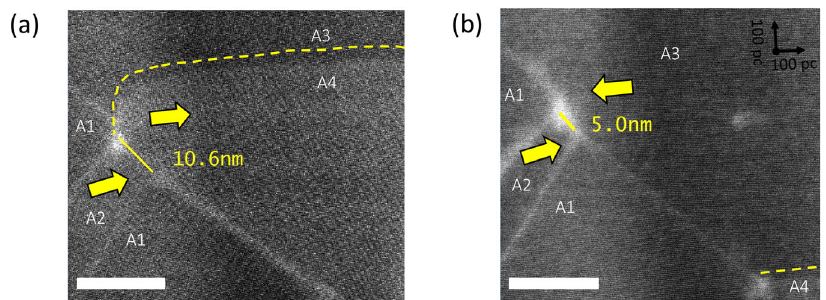
Fig. 5 In situ switching narrows the charged needle point. The domain wall region ( a ) before and ( b ) after switching by the electron beam. Distance labels indicate the length of the needle tip in each case. From the initial neutral con fi guration in ( a ), the junction becomes charged in ( b ) after movement of the 180° (dashed yellow) domain wall to the bottom right corner. The needle point narrows from 10.6 nm to 5 nm in response. Scale bars =